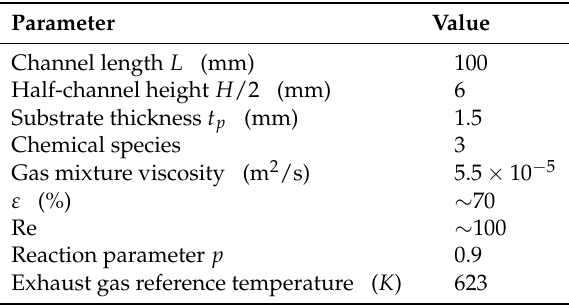
Table 1. Main simulation parameters for the SCR channel case.